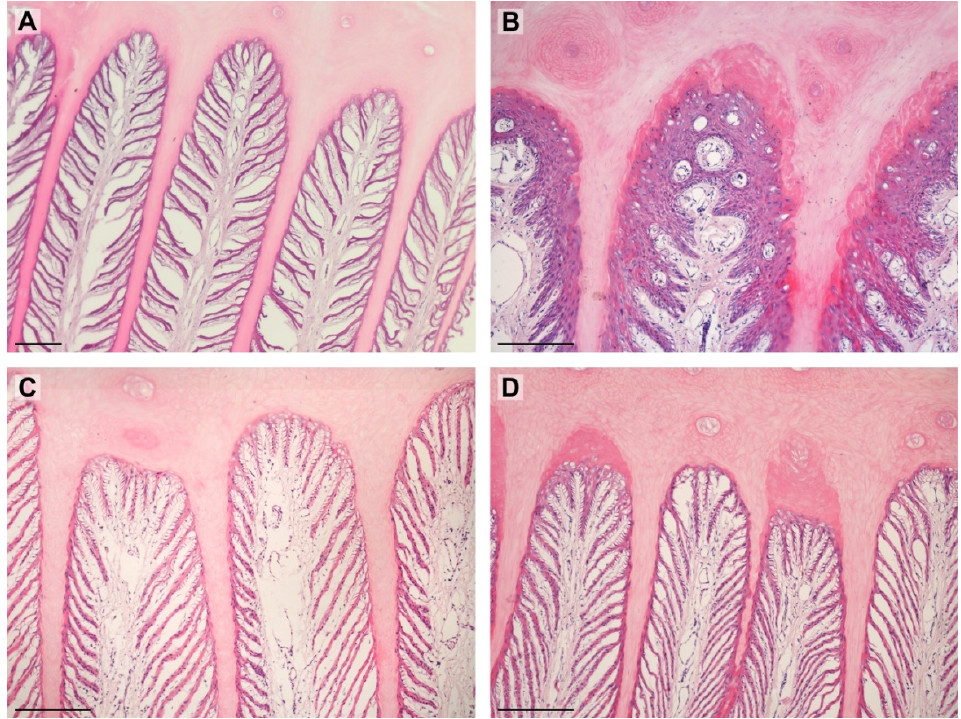
Figure 3. Images show PDLs in examined horses. ( A )—separated (lean); ( B )—proliferative (lean); ( C )—standard (obese); ( D )—keratinized (obese). Scale bar = 200 µm.